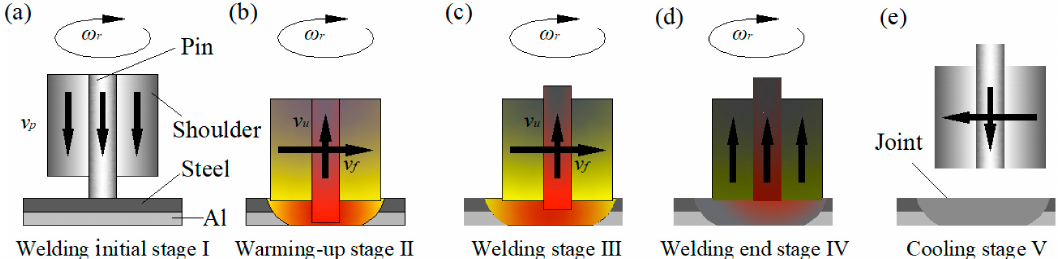
Figure 1. The welding process of the dissimilar Al / steel retractile keyhole-free friction stir spot welding (FSSW), ( a ) welding initial stage I, ( b ) warming-up stage II, ( c ) welding stage III, ( d ) welding end stage IV, ( e ) cooling stage V.